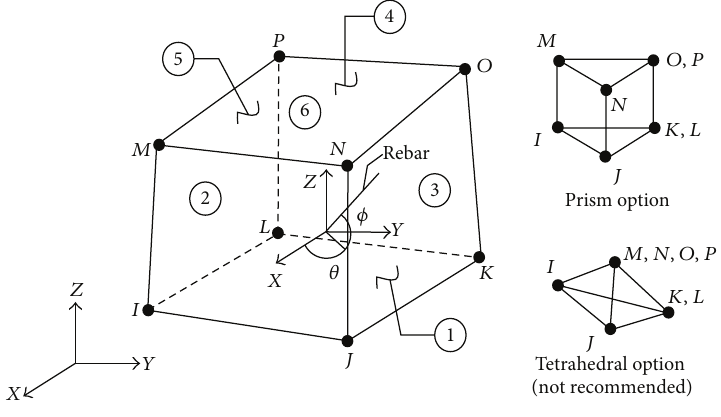
Figure 4: Geometry of SOLID65 in ANSYS 10.0 platform.